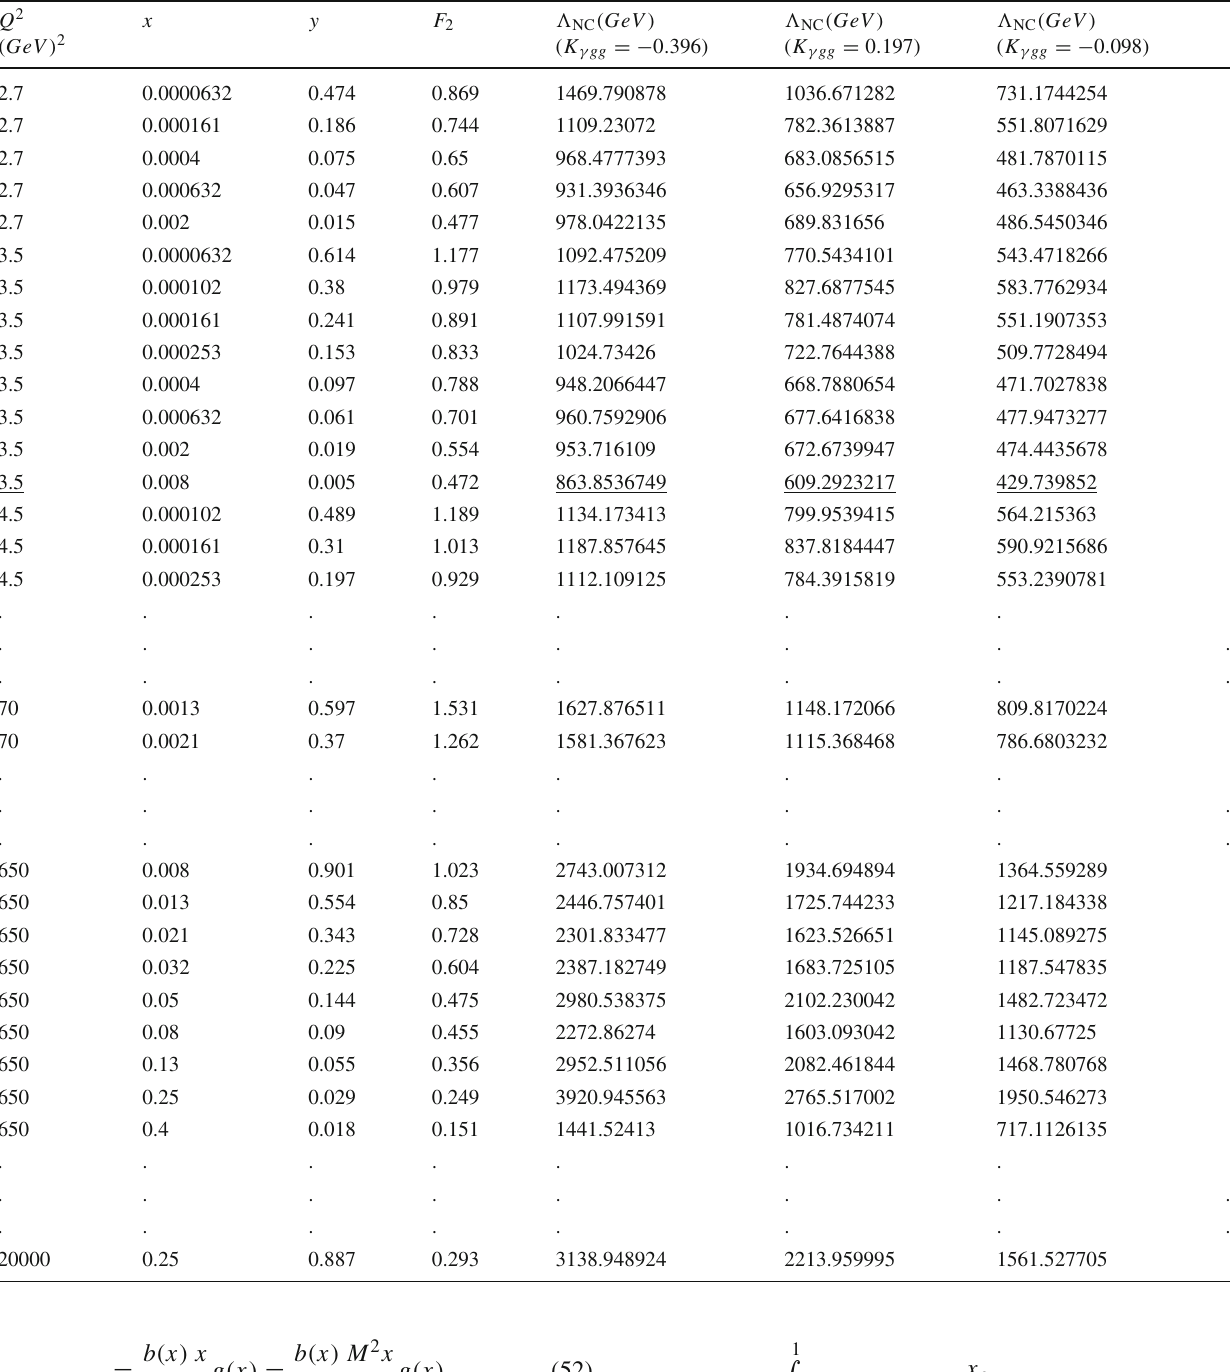
Table 3 Sample numerical values for the (cid:4) NC scale in the 2 . 7 < Q 2 < 20000 GeV 2 range at different values of the parameter K γ gg Q 2